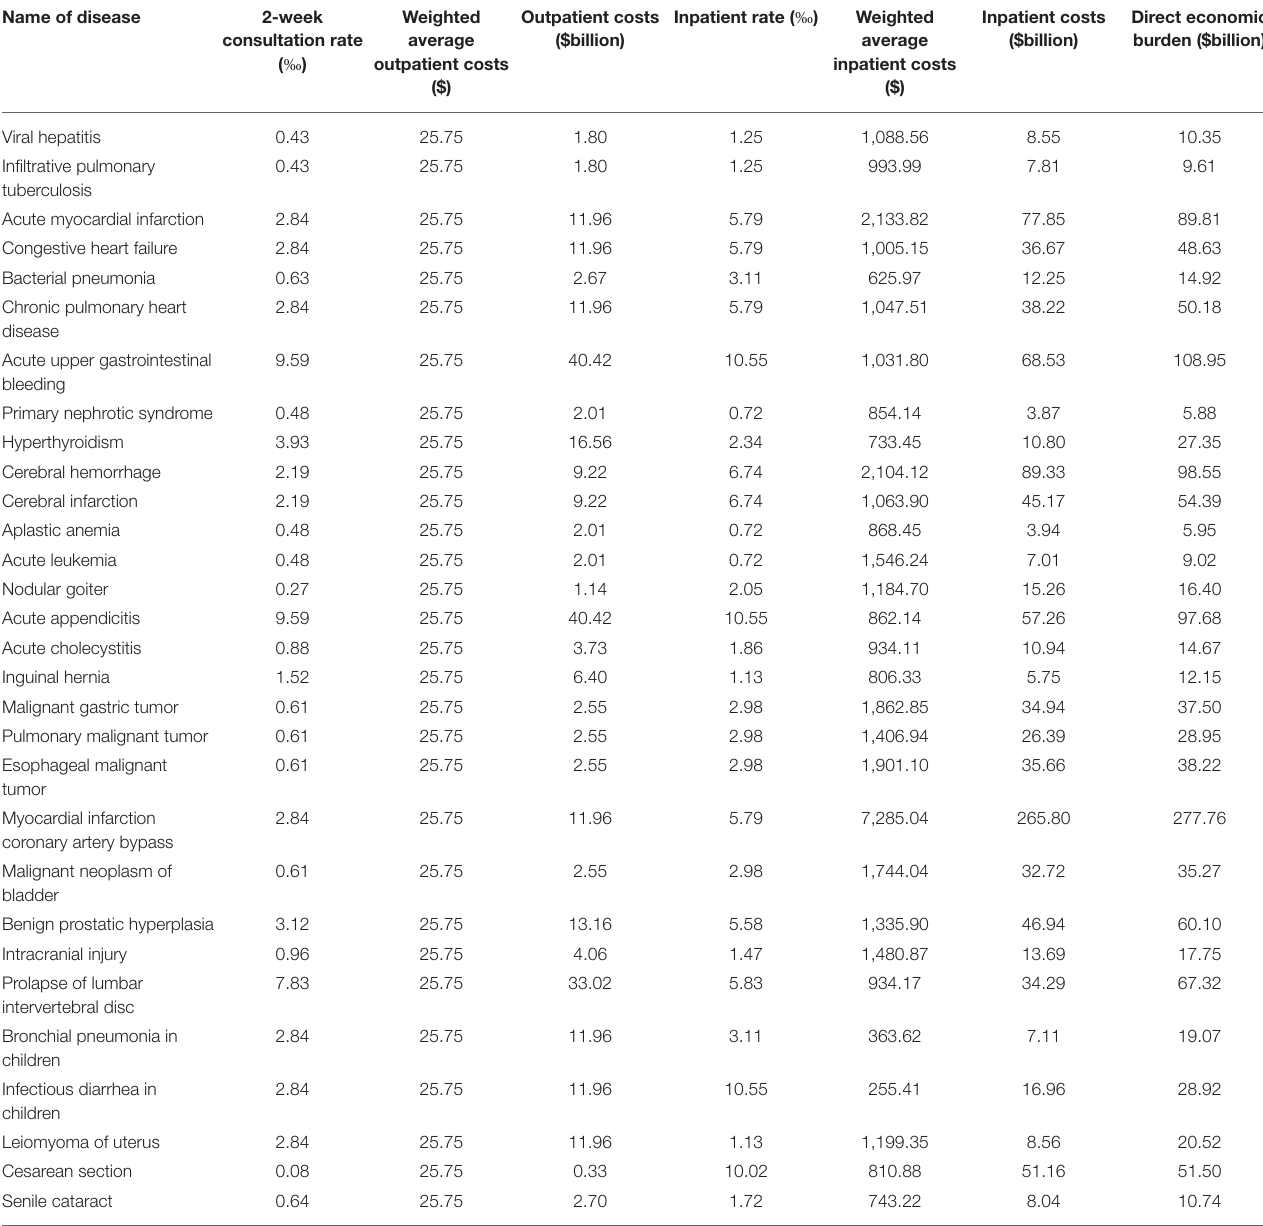
TABLE 2 | Direct economic burden of 30 types of diseases in rural areas in China in 2013. Name of